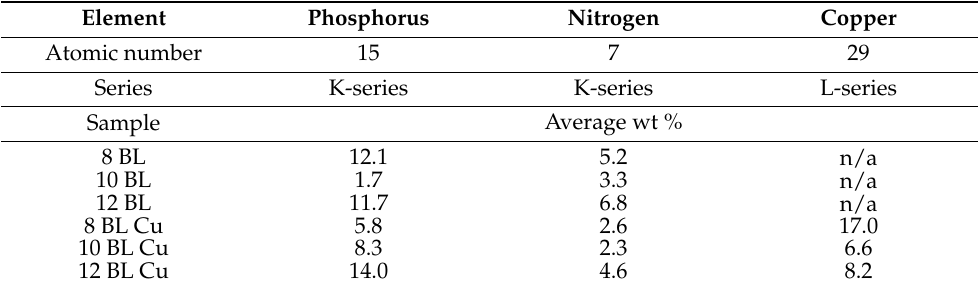
Table 5. Quantity of phosphorus, nitrogen, and copper in post-burn for PA/CH-urea and PA/CH- urea + Cu 2+ coated cotton.